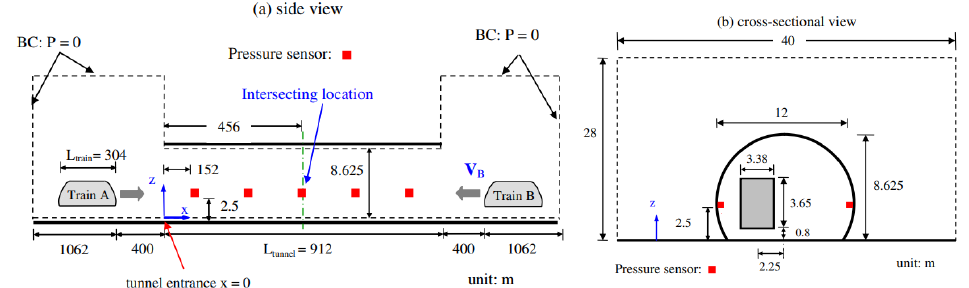
Figure 7. Schematic diagram of computational domain and boundary condition.[43].